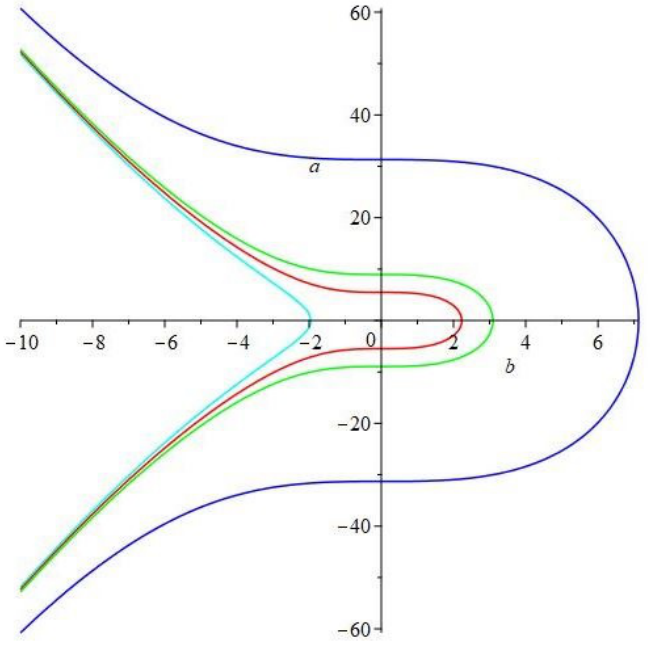
Figure 10. The elliptic curves associated with s 0 = − 1 and q 0 ∈ { 1, − 51, − 101, − 1001 }